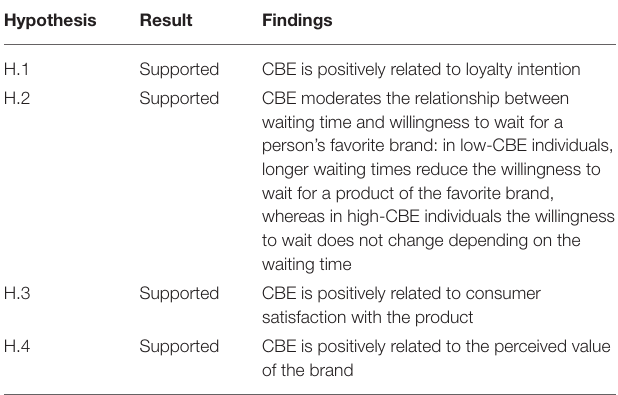
TABLE 4 | Summary of hypothesis